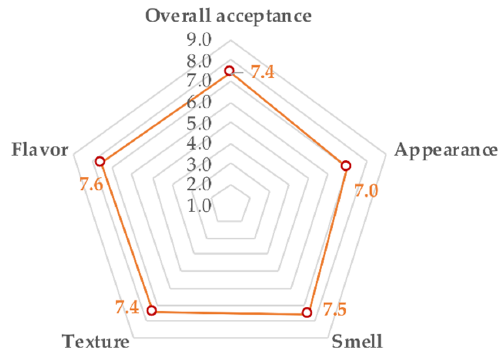
Figure 5. Radial graph of the sensorial characteristics of reduced-fat, preservative-free (AI) pork and chicken meatballs performed by consumers ( n = 84) via a hedonic test.